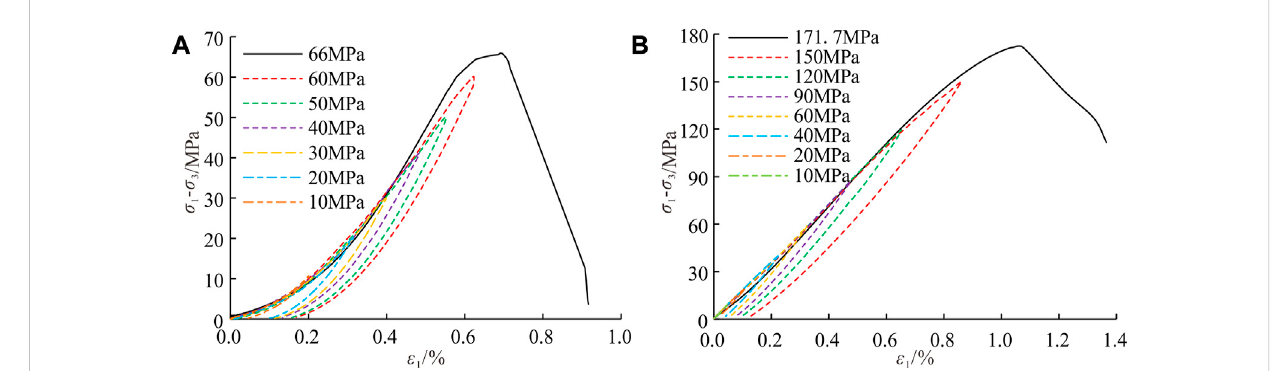
FIGURE 3 Stress-strain curves of sandstone under SCLU. (A) Con fi ning pressure σ 3 = 0 MPa. (B) Con fi ning pressure σ 3 = 20 MPa.